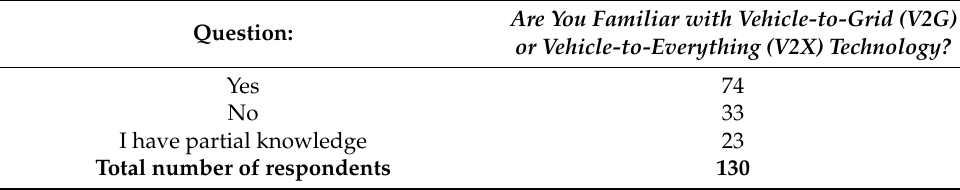
Table A7. Detailed responses to question